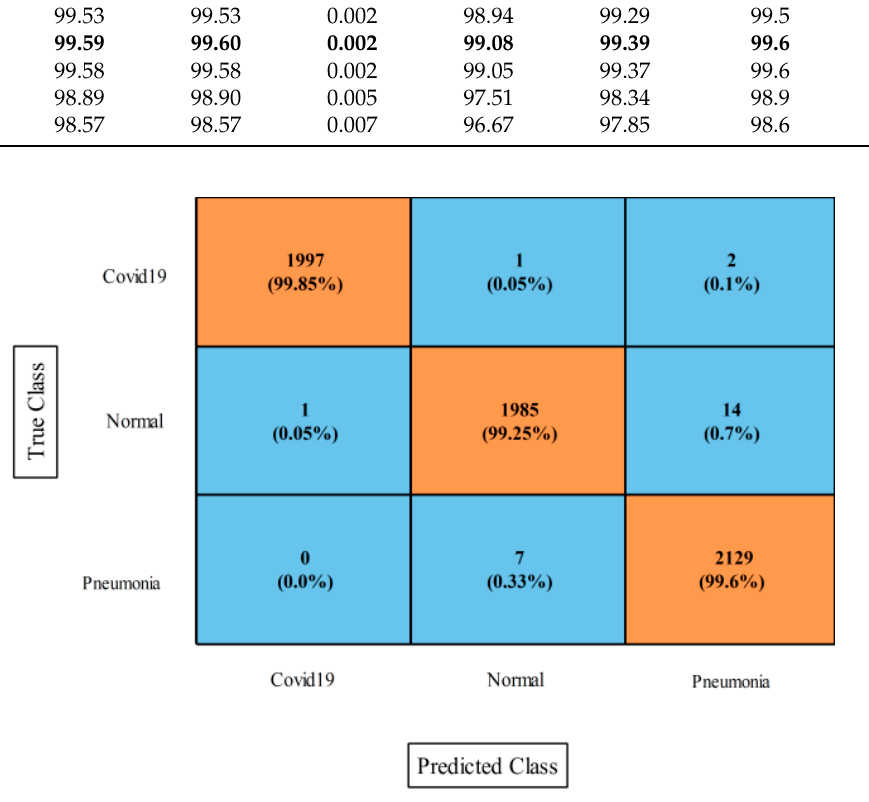
Figure 6. Confusion matrix of MNN for proposed fusion method on Chest X-ray dataset.